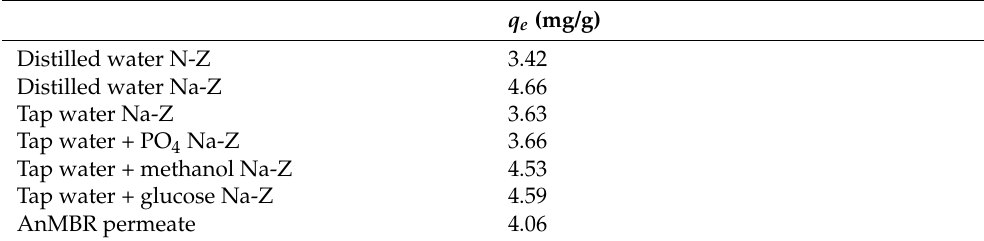
Table 5. Adsorption capacity ( q e ) in the different isotherm tests carried out when C e = 28.8 mg NH 4